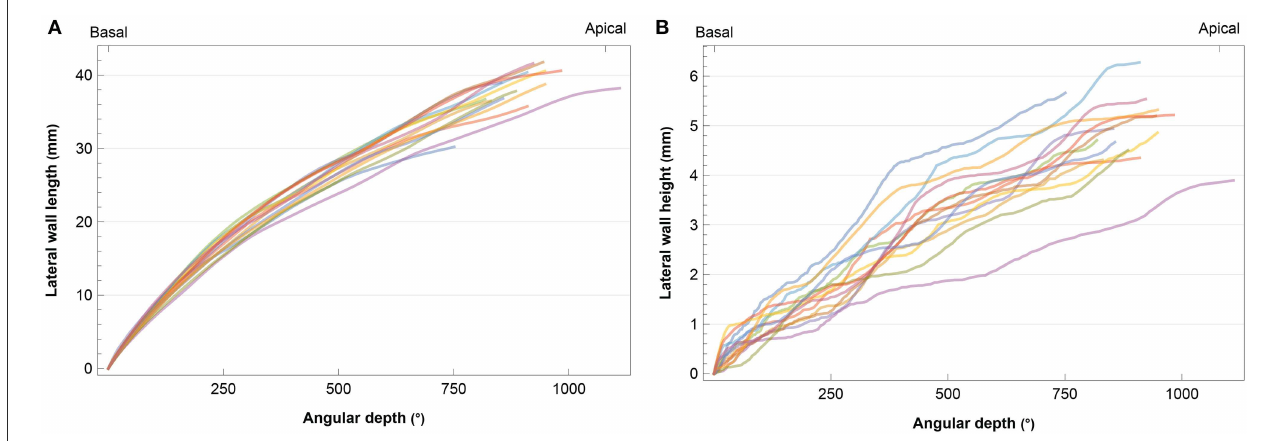
FIGURE1 Individual cochlear angular depth in relation to (A) length and (B) height of the lateral wall. Each subject is represented by a different